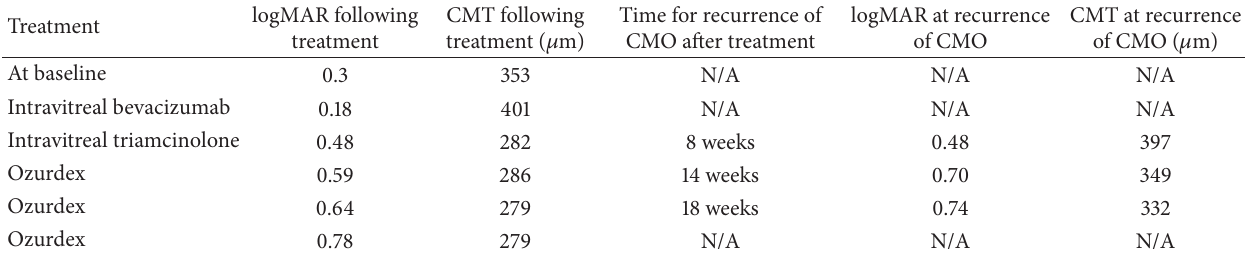
Table1:Tabledemonstratingvisualacuity(measuredusinglogMAR)andcentralmacularthickness(CMT)measuredusingocularcoherence tomography in right eye of patient with macular telangiectasia type 1. Data is demonstrated at baseline, 2–6 weeks following each treatment, and after a recurrence of cystoid macular oedema